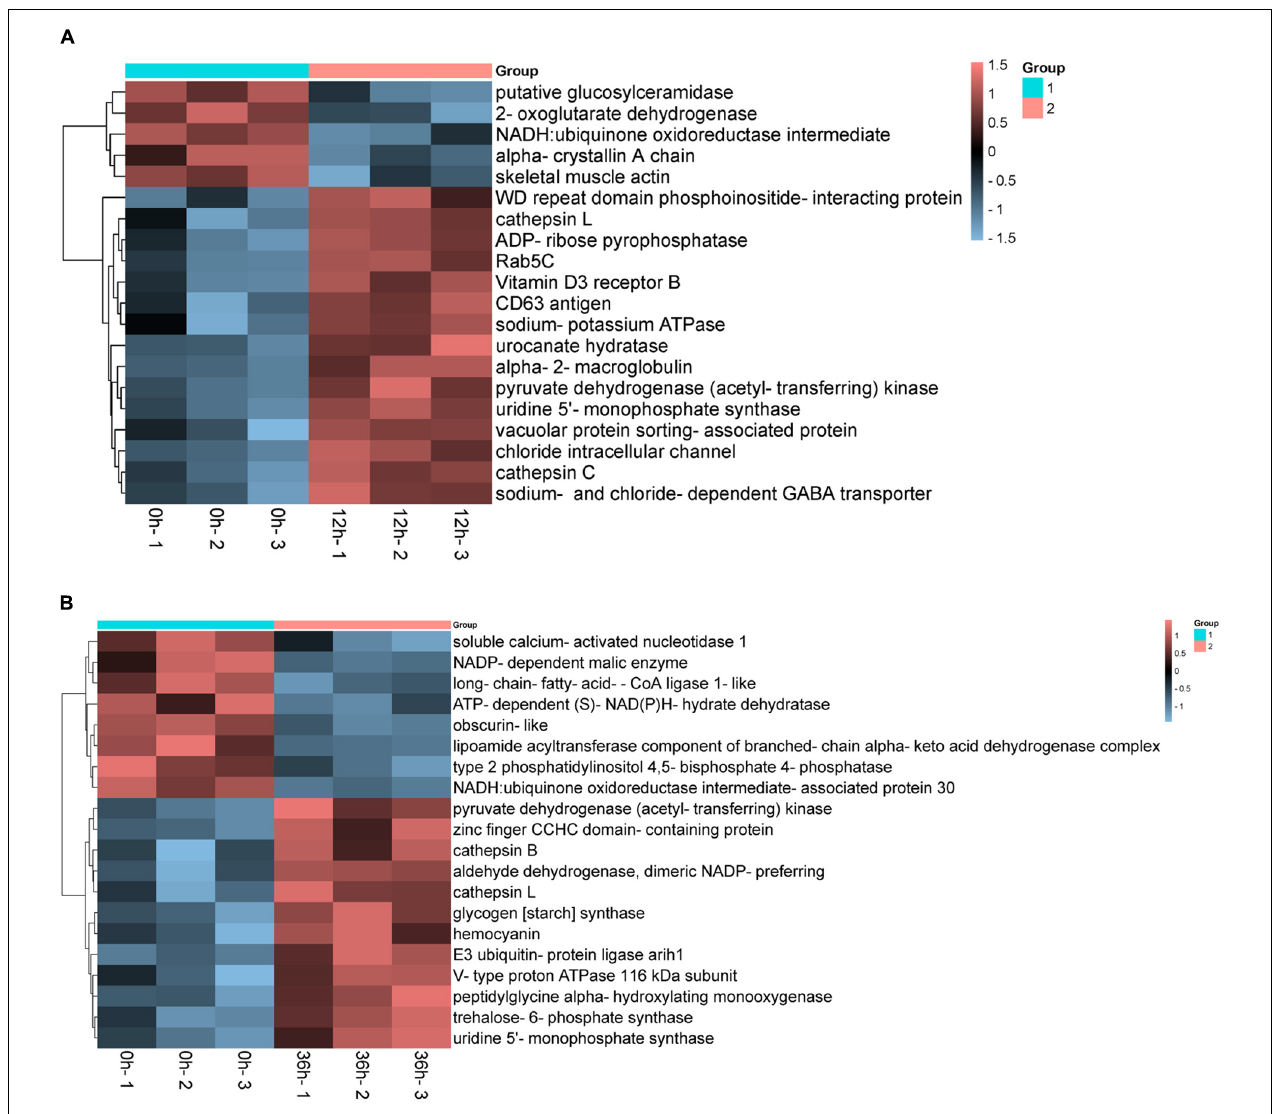
FIGURE 7 | Cluster heat maps of differentially expressed proteins (DEPs) associated with alkalinity stress in the proteome. (A) Hierarchical cluster analysis of saline-alkaline related DEPs in 0 vs. 12 h. (B) Hierarchical cluster analysis of saline-alkaline related in 0 vs. 36 h based on the data of p < 0.01.